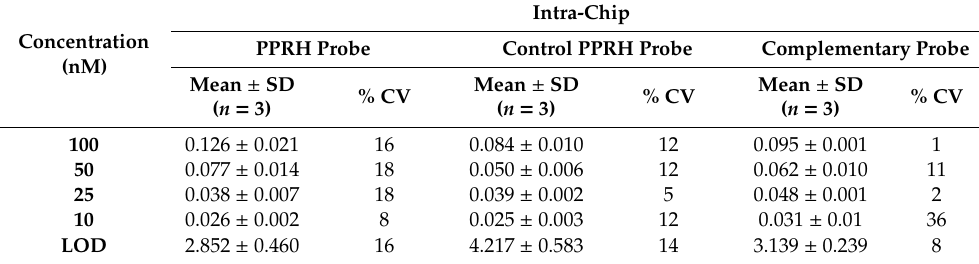
Table A1. Variability of the SPR sensor signal intra- and inter-assays for mtLSU rRNA detection. The mean ± SD are from three replicates performed in the same or different biofunctionalized sensor chips, respectively.